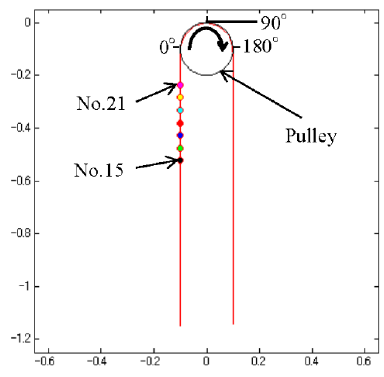
Figure 8. Shape of a wire rope at start time.